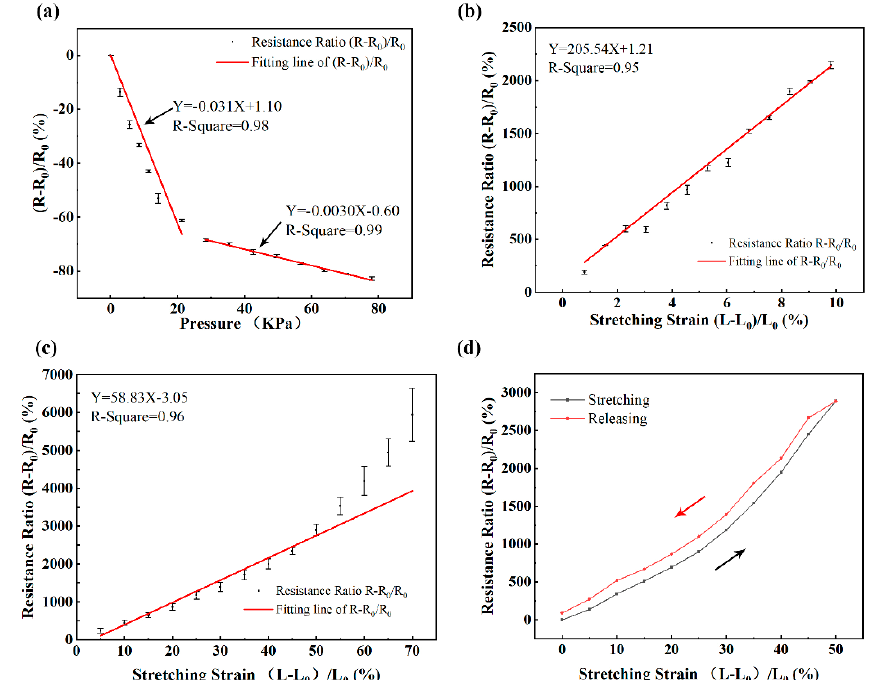
Figure 3. The mechanical response of the GNP sheets and the graphene sensors. ( a ) The relationship of the resistance ratio of the GNP sheet with the applied pressure. ( b ) The relationship of the resistance ratio of the GNP sheet with its stretching strain. ( c ) The relationship of the resistance ratio of the GNP sheet packed with PU film with its stretching strain. ( d ) Hysteresis performance of the graphene sensor. R 0 is the initial resistance value. R is an instantaneous resistance value. L 0 is the length of the GNP sheet. L is the instantaneous length of the GNP sheet.